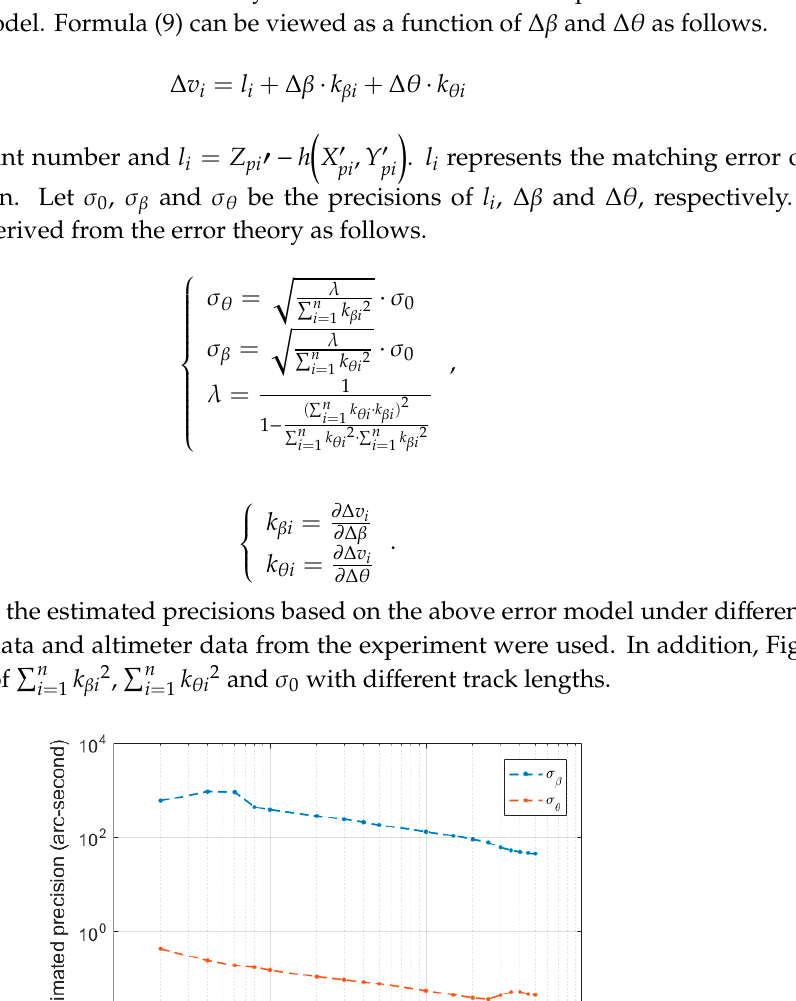
Figure 19. The estimated precision under different track lengths.